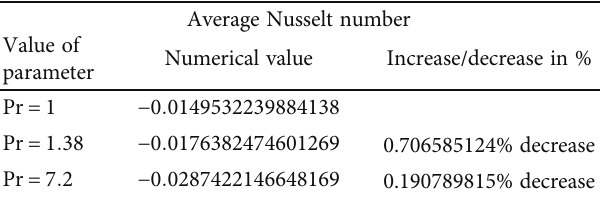
Table 7: Variability of the curve when Y = 1 in Figure